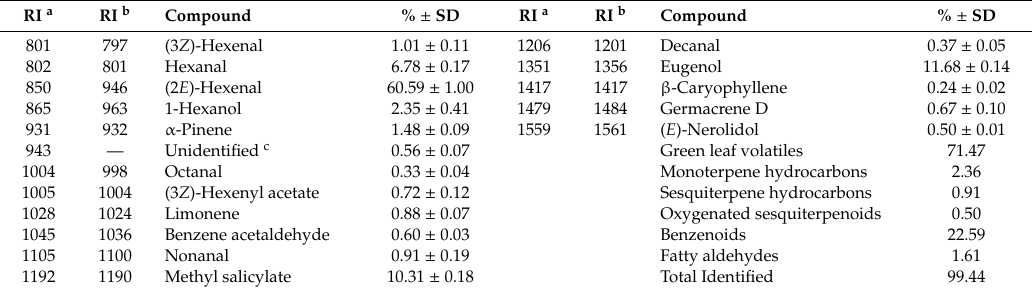
Table 4. Chemical composition of the essential oil of Eutrochium purpureum (L.) E.E.